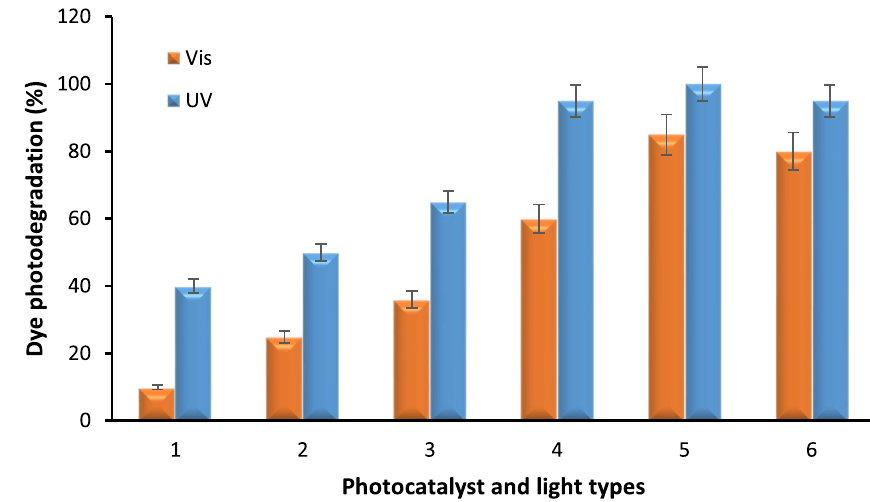
Fig. 7 The dye photodegradation over: 1 TiO 2 , 2 TiO 2 – Fe(1:0.05), 3 TiO 2 – Fe(1:0.1), 4 TiO 2 – Fe(1:0.2), 5 TiO 2 – Fe(1:0.5), and 6 TiO 2 – Fe(1:1) under visible and UV lights . (Dye concentration 50 mL photocatalyst weight =